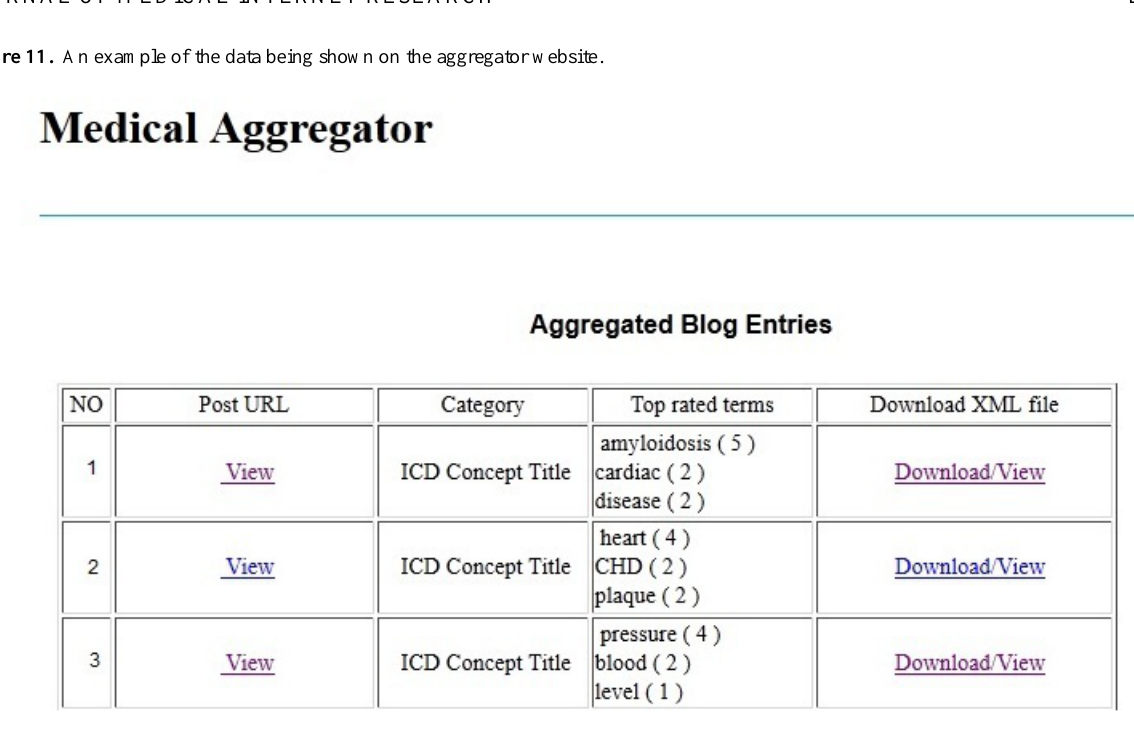
Figure 11. An example of the data being shown on the aggregator website.